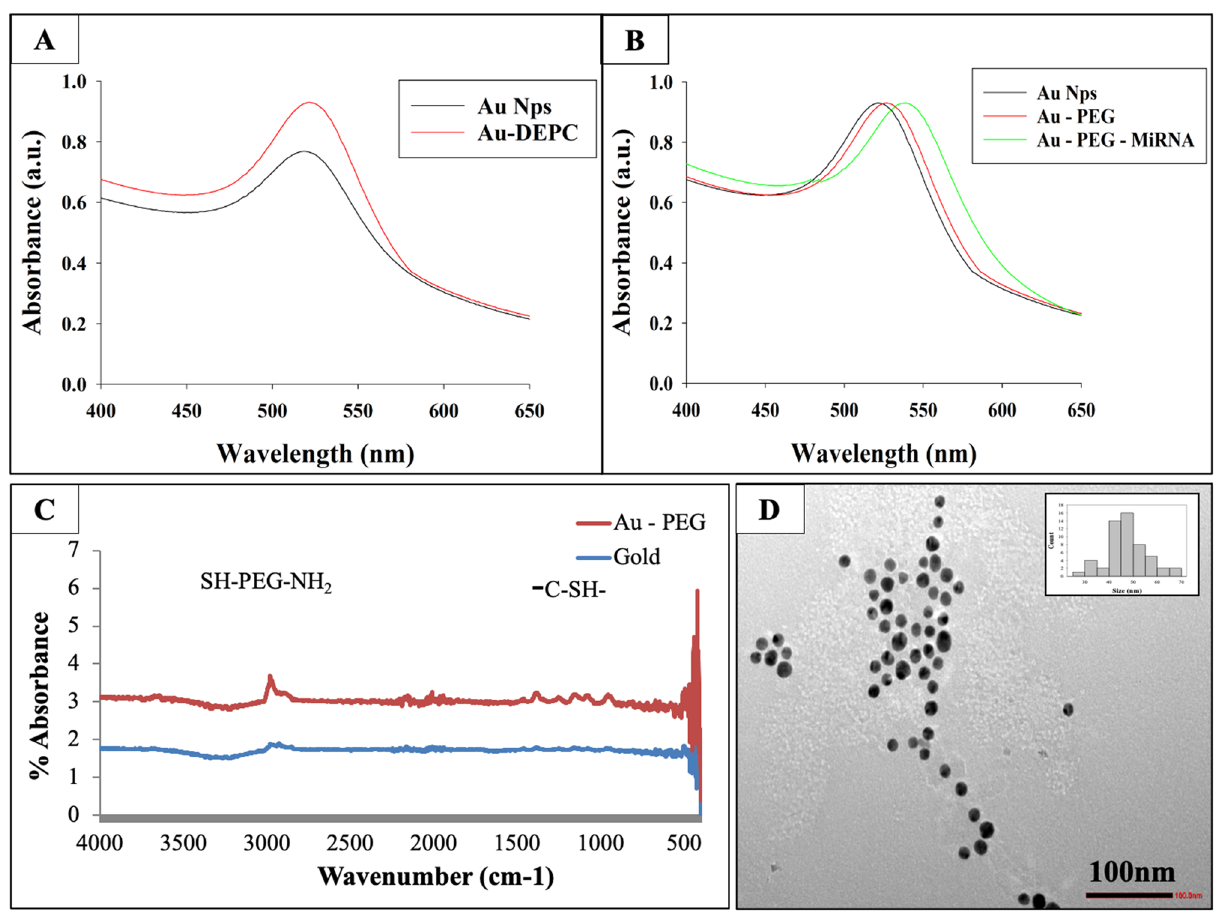
Figure 1. Characterization of formulated gold nanoparticles. ( A ) UV–Vis Spectra obtained for gold nanoparticles and DEPC treated gold nanoparticles. ( B ) UV–Vis Spectra of DEPC treated gold nanoparticles (Au NPs), PEG capped Au NPs (Au—PEG) and MiRNA coated PEG capped Au NPs (Au–PEG–MiRNA). ( C ) FTIR spectra for citrate capped AuNPs (bottom) and MiRNA–PEG (top) capped Au NPs represent the binding of NH 2 -PEG-SH molecule on the surface of AuNPs. ( D ) Transmission Electron Microscopy (TEM) image obtained for PEG coated gold nanoparticles inset: histogram indicating particle size.